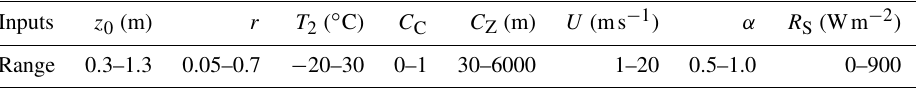
Table 1. Range of parameters used for studying the sensitivity of L − 1 . For each range, six points were linearly spaced within the range. This amounts to 6 8 (1.7 million) combinations of input variables to be evaluated, resulting in 6 8 Jacobian matrices. In the table, z 0 is the roughness length, r is the surface albedo, T 2 is the temperature at the height of 2m, C C is the cloud cover, U is the wind speed at 10m, α is the Priestley–Taylor moisture parameter, and R S is the solar irradiance.